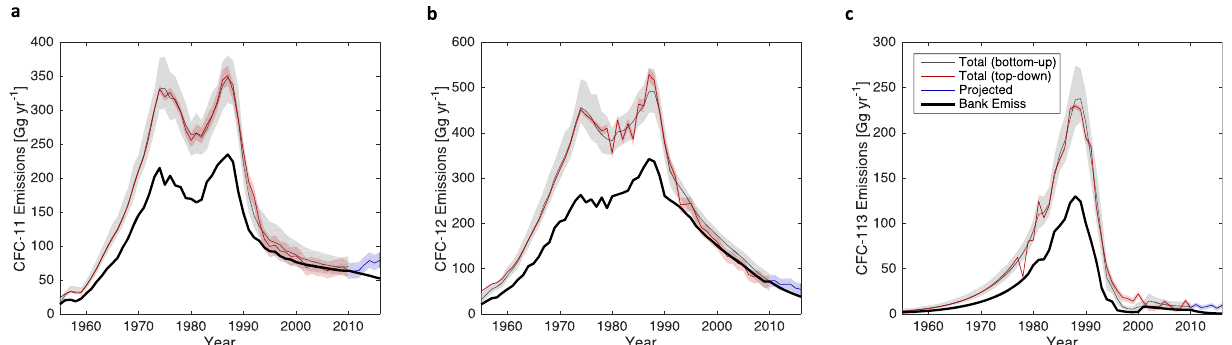
Fig. 5 Posterior bank and total emissions. Posterior emissions (red and grey), median posterior bank emissions (black), observationally derived emissions with posterior lifetimes (blue) for ( a ) CFC-11 ( b ) CFC-12, and ( c ) CFC-113. Shaded regions indicate the 95% con fi dence interval.